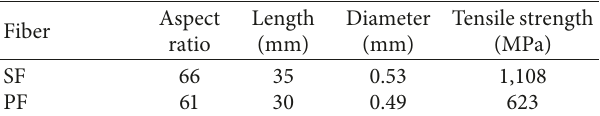
Table 4: Physical properties of fibers.